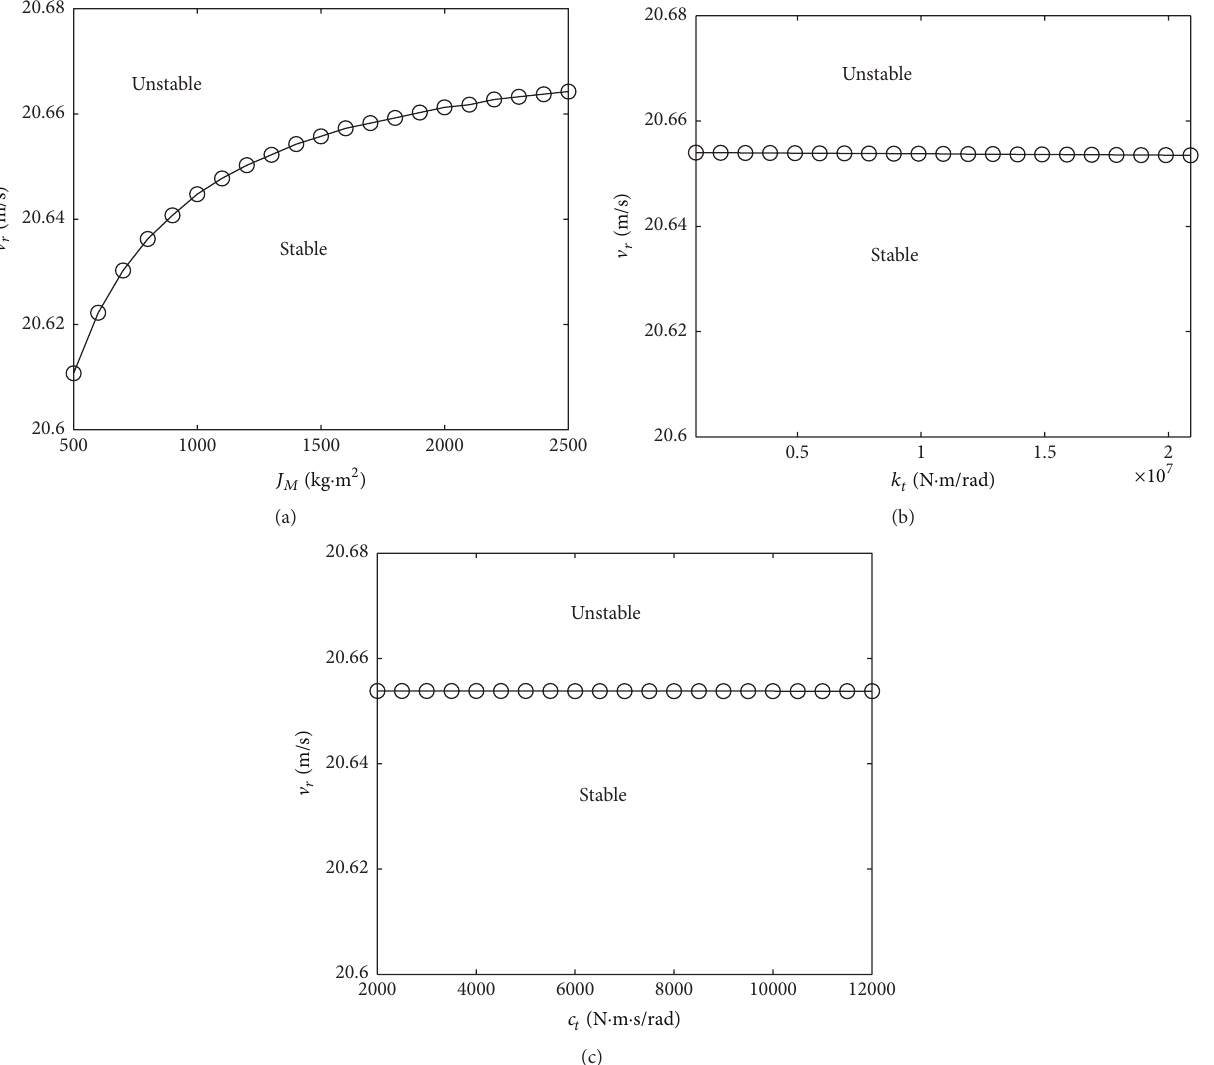
Figure 18: Influences of torsional structural parameters on system